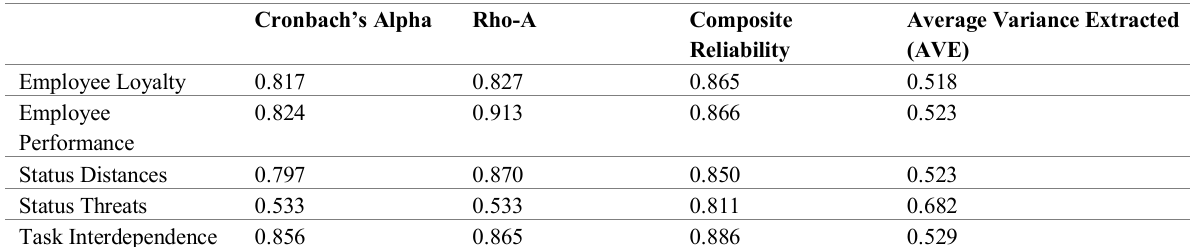
Table 1 : Reliability and validity